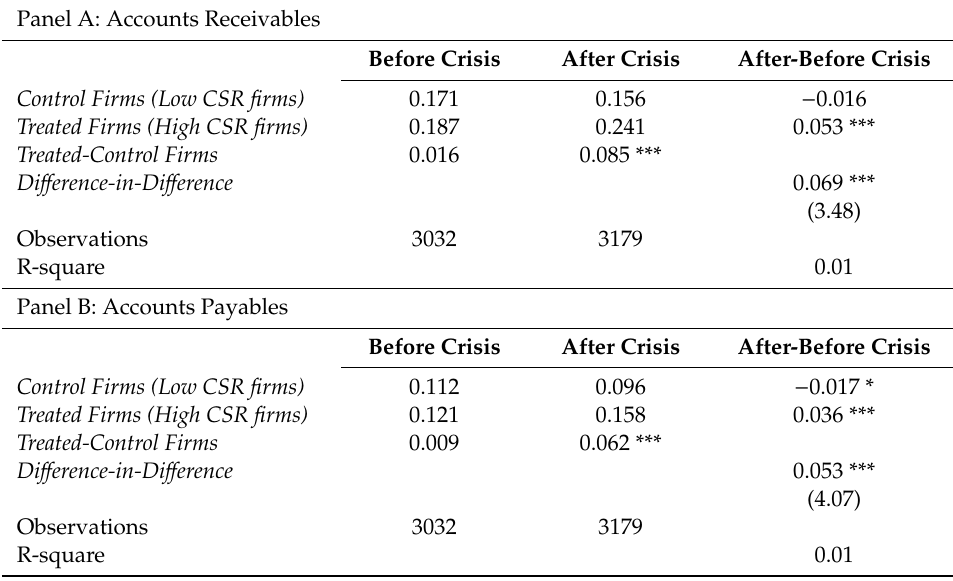
Table 9. Di ff erence-in-Di ff erence: Exogenous shock of